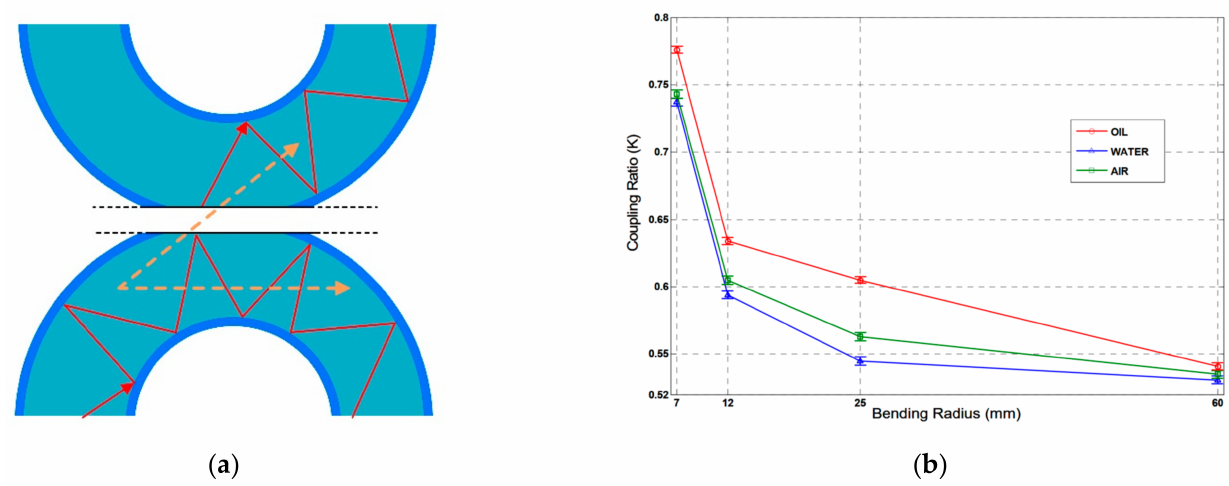
Figure 15. The schematic diagram of the side-polished POF coupler ( a ), and the variations of K for the probe with different bending radius in different liquids ( b ) [111].